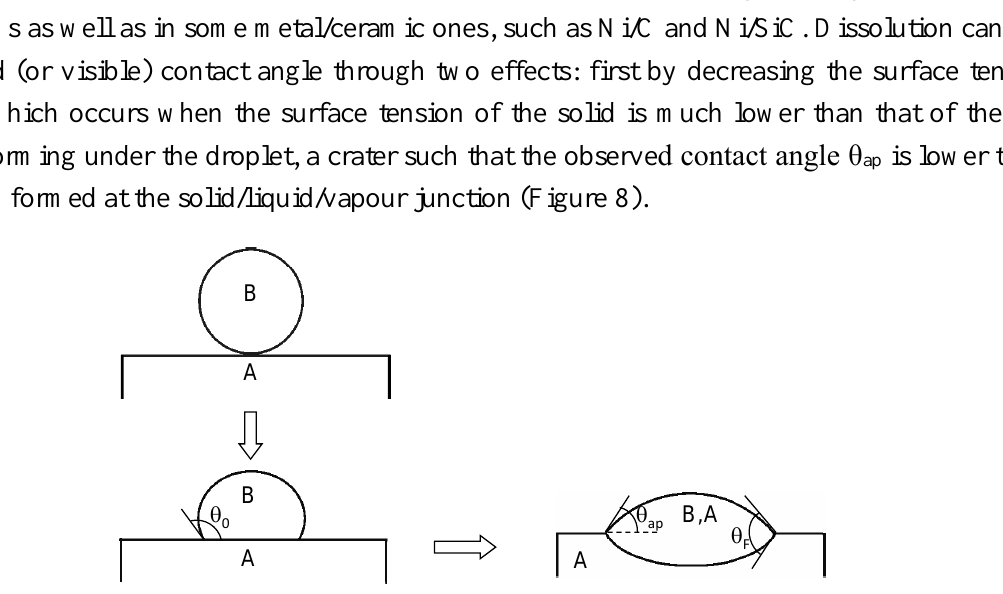
Figure 8. Dissolutive wetting: Wetting of a liquid metal B leads rapidly, within a few ms, to a first contact angle θ 0 corresponding to the intrinsic contact angle of pure B in metastable equilibrium with A. Then, the wetting process continues with the formation of a crater until saturation of B in A